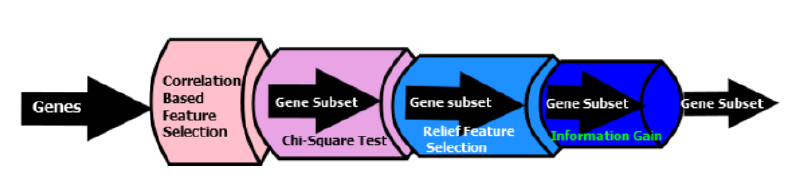
Figure 3. Occurrence Analysis for Feature Reduction Technique.